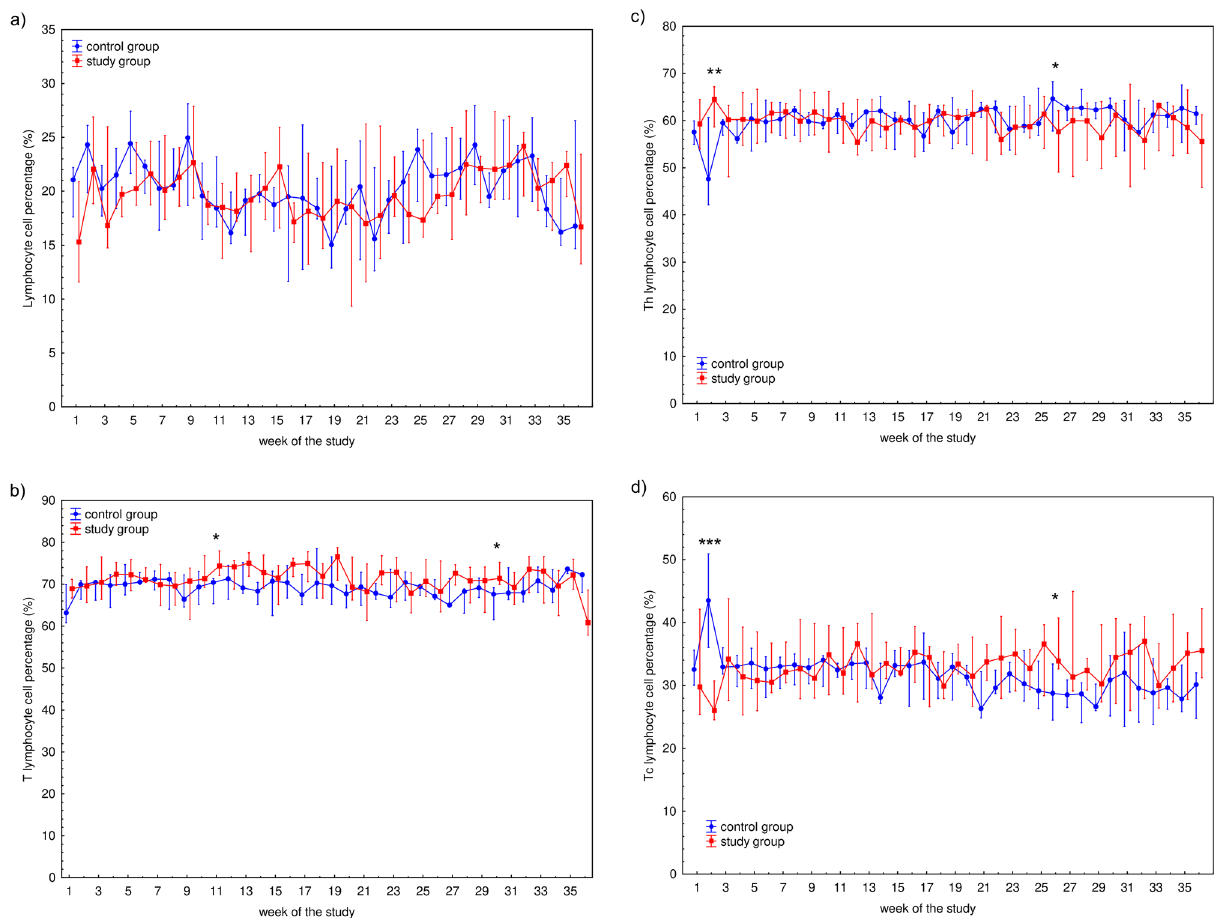
Figure 3. Median of the percentage of white blood cells population: ( a ) lymphocyte (CD45 + ) subsets, including: ( b ) T cells (CD3 + ), ( c ) helper/inducer T cells (Th; CD3 + CD4 + ), ( d ) cytotoxic T cells (Tc; CD3 + CD8 + ), ( e ) natural killer cells (NK; CD3 – CD16 + /CD56 + ), and ( f ) B cells (CD19 + ) of studied subjects’ blood samples measured during 36-week study among 22 professional soccer players. Blood immunophenotyping protocol was performed using commercial antibodies assay kit (BD Multitest IMK Kit) according to the manufacturer instructions and analyzed using BD Accuri C6 flow cytometer. The midpoint represents median; whiskers represent Q1-Q3 range. The significance of differences between the control and study groups was calculated using the Mann–Whitney U test. P value < 0.05 was considered to be significant. * P < 0.05; ** P < 0.01; *** P <